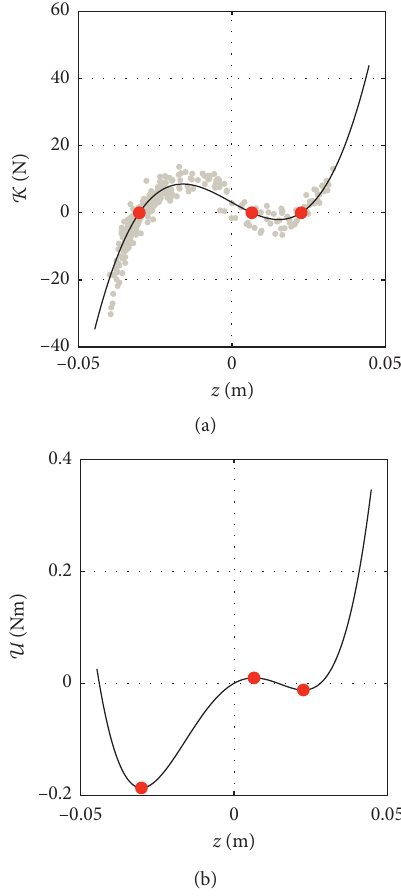
Figure 17: RFS estimation of the restoring force K ( z ) (a) and the corresponding potential U ( z ) (b). Red dots: stable and unstable equilibrium positions; gray dots: restoring surface for | _ z | < ε